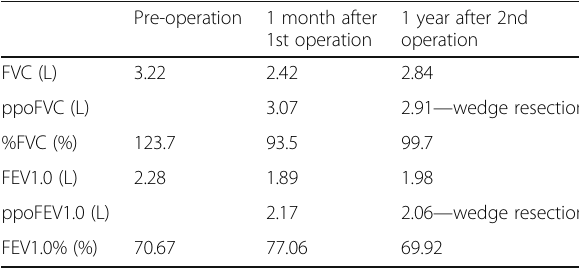
Table 1 Results of respiratory function tests over time and predicted postoperative function calculated by the number of resected subsegments Pre-operation 1 month after 1st operation